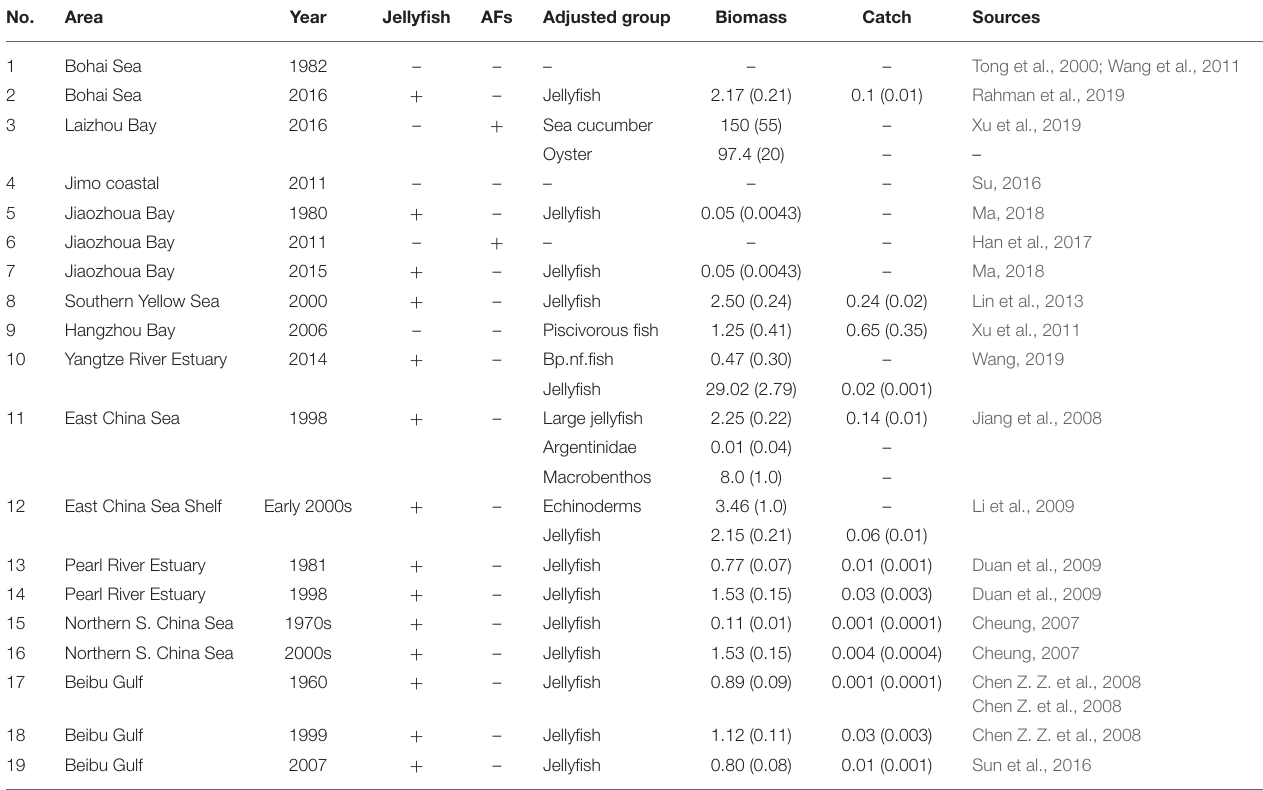
TABLE 1 | Summary and adjustment of 19 adjusted Ecopath models in China’s seas (biomass in tonnes km − 2 ; catch in tonnes km − 2 year − 1 ).